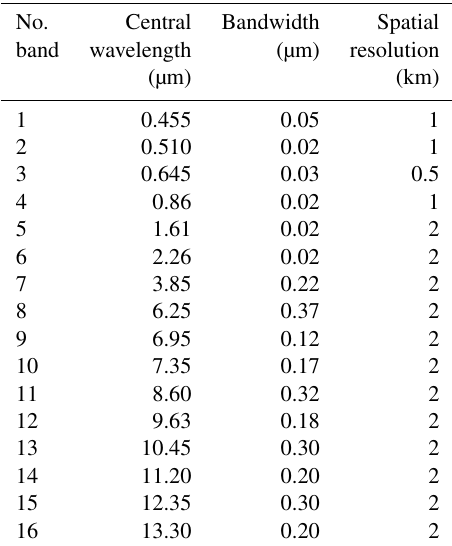
Table 1. Characteristics of the spectral channels of Himawari-8 AHI.